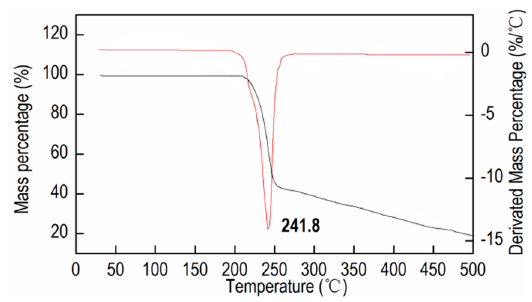
Figure 5. TG ‐ DTG curve of 2(SCZ) ∙ BTO at the heating rate of 5 °C ∙ min − 1 .